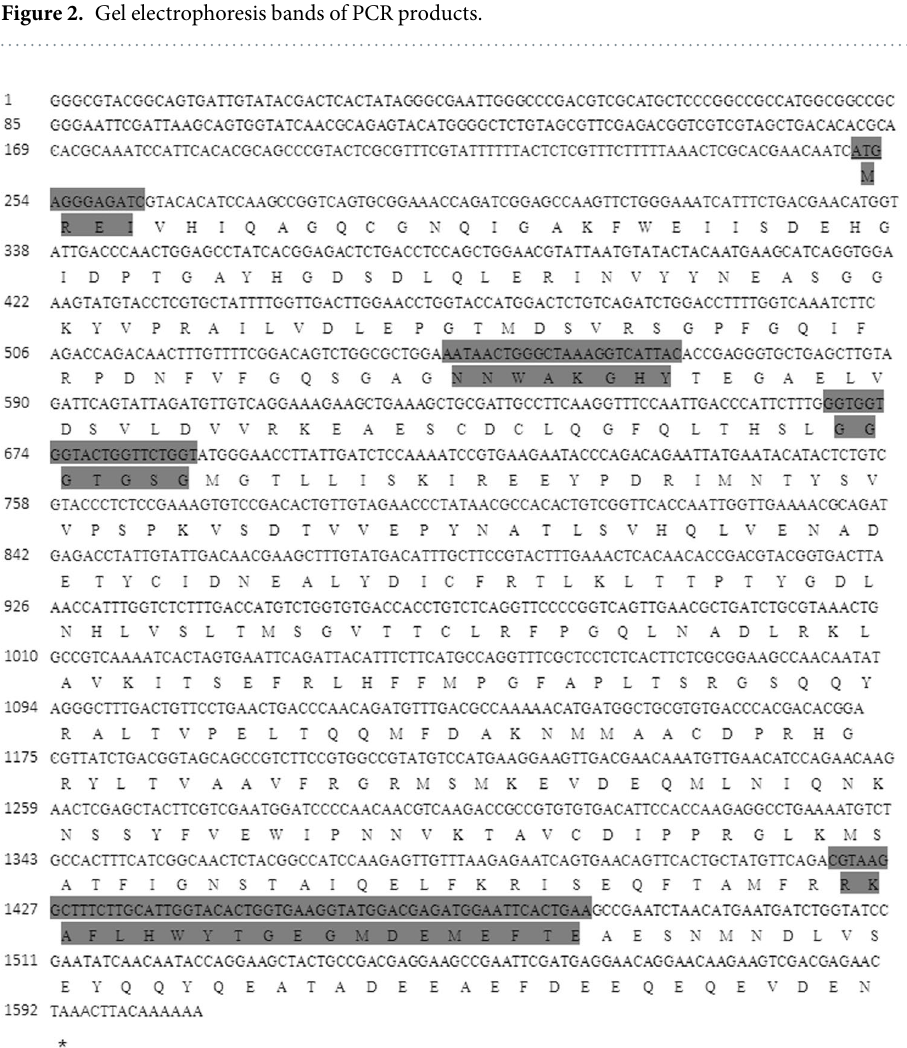
Figure 2. Gel electrophoresis bands of PCR products.